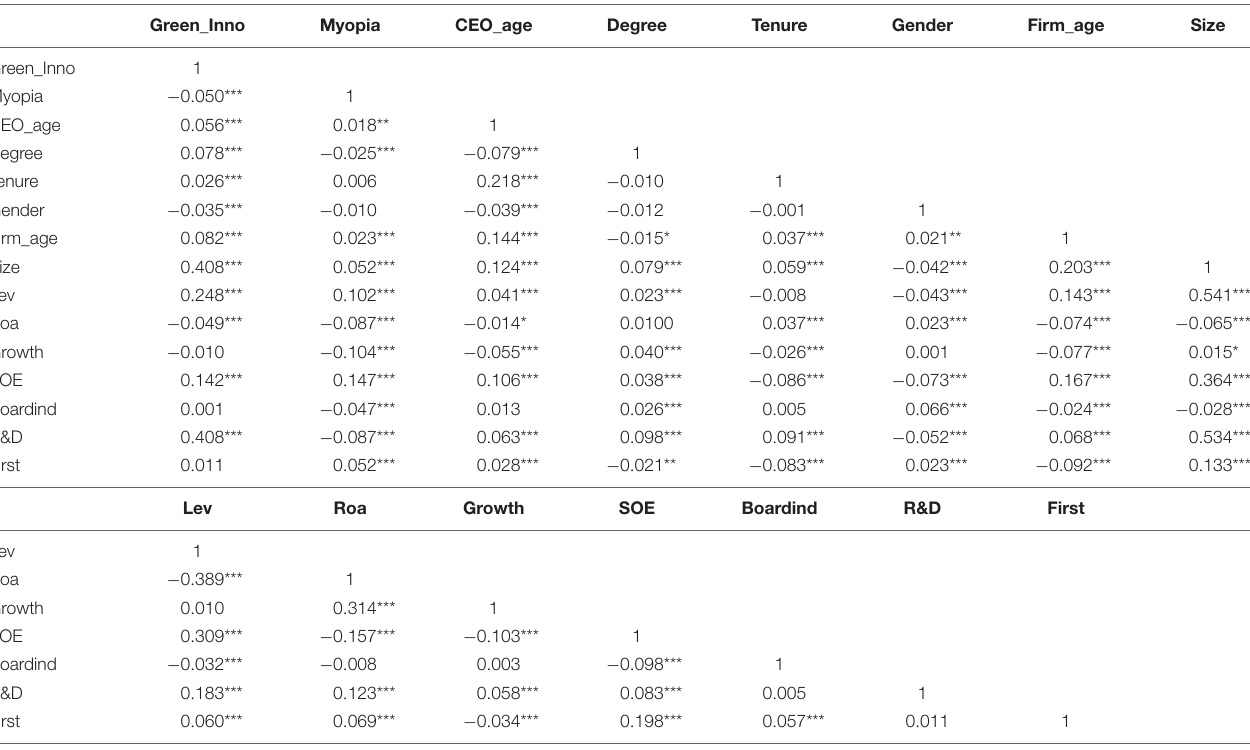
TABLE 3 | The Pearson correlation